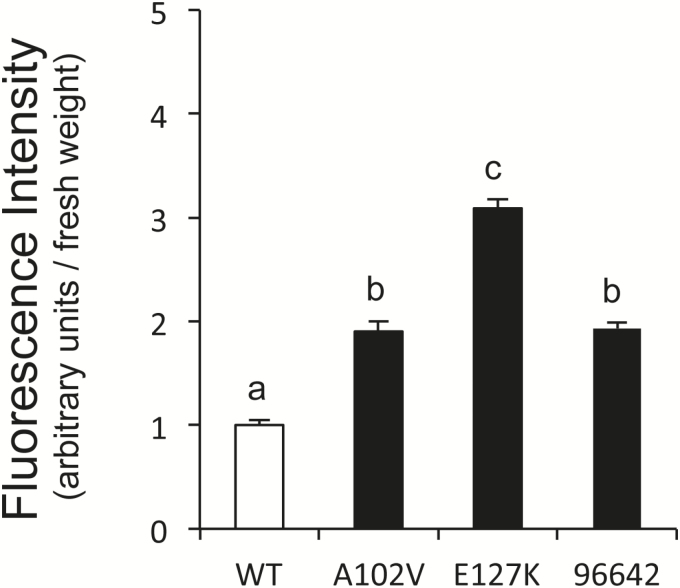
Quantification of NO released from roots of WT and mutant plants after incubation with M. loti MAFF303099. The fluorescence intensity of the DAF-FM solution in the rooting medium was measured with a plate reader and expressed as relative fluorescence intensity per fresh weight of roots. Means (± SE; n=9) denoted by the same letter do not significantly differ based on Duncan’s multiple range test at P=0.05.